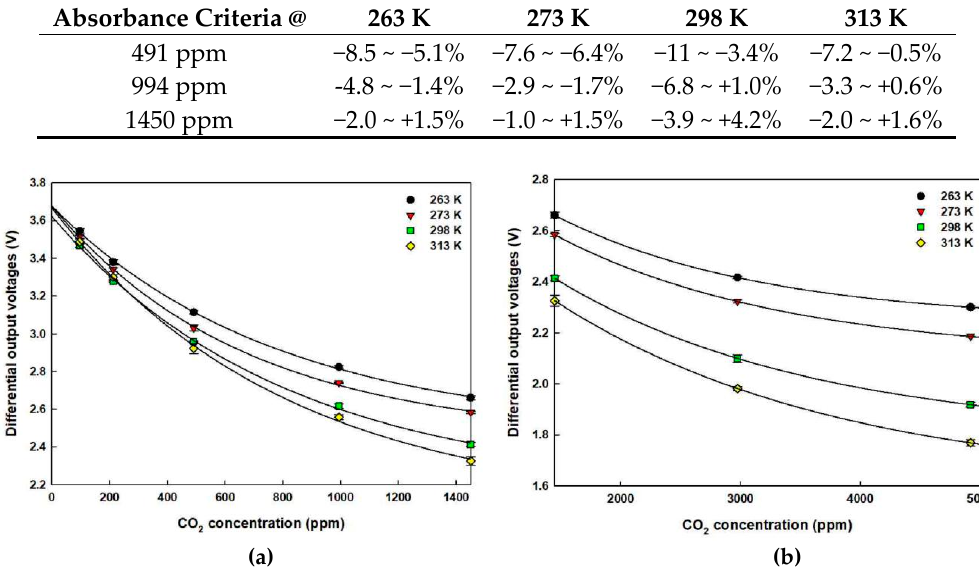
Figure 2. Regression analysis of the differential output voltages of IR detectors according to the IR absorption criteria at 1450 ppm: ( a ) below 1450 ppm; ( b ) above 1450 ppm CO 2